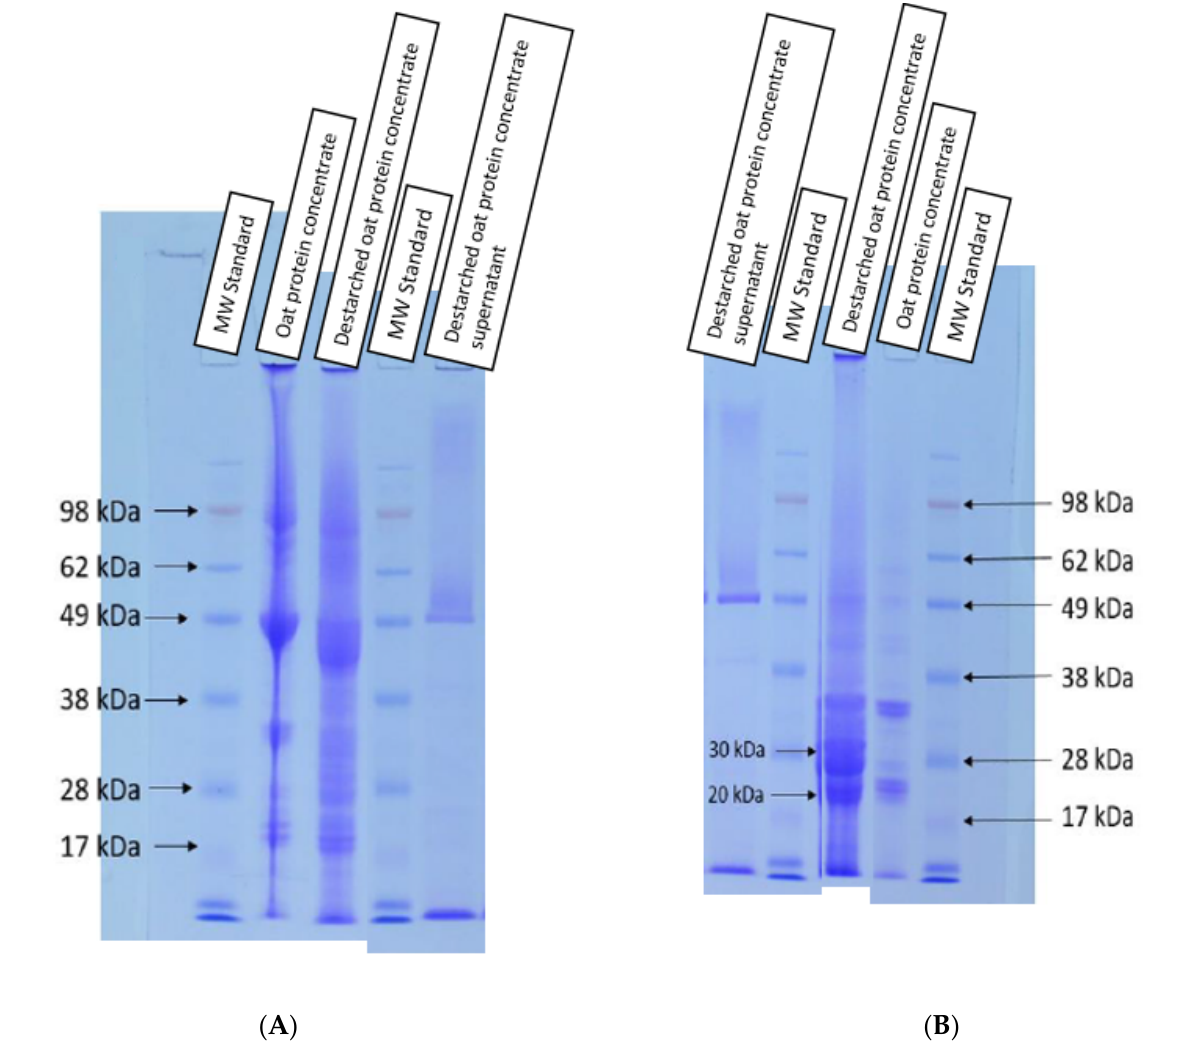
Figure 1. ( A ) Non-reduced 10% Bis-Tris gel and ( B ) mercaptoethanol-reduced samples of 10% Bis-Tris gel with indications of the sample molecular weight (MW standard), oat protein concentrate (starting material), destarched oat protein concentrate and destarched oat protein concentrate supernatant.